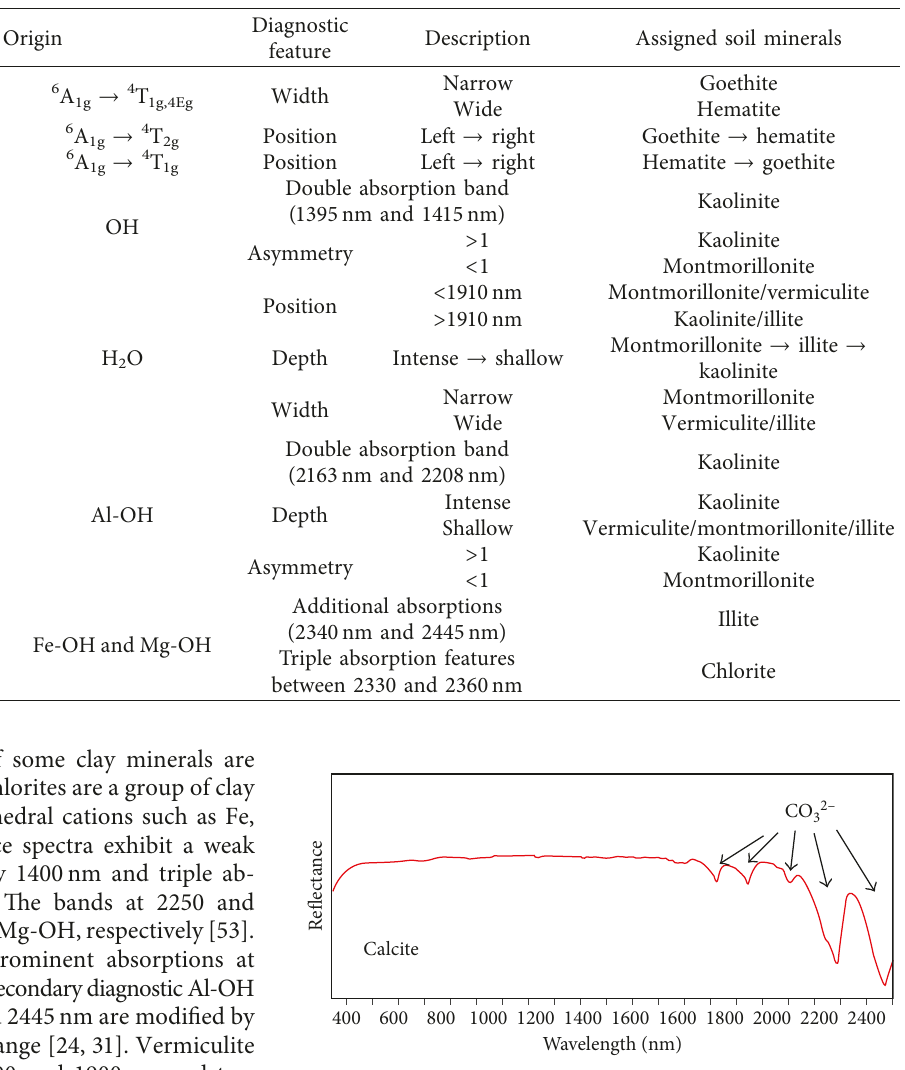
Figure 5: Absorptions for calcite in the VNIR domain, caused by overtones and combinations of fundamental vibrations of the CO 32 −